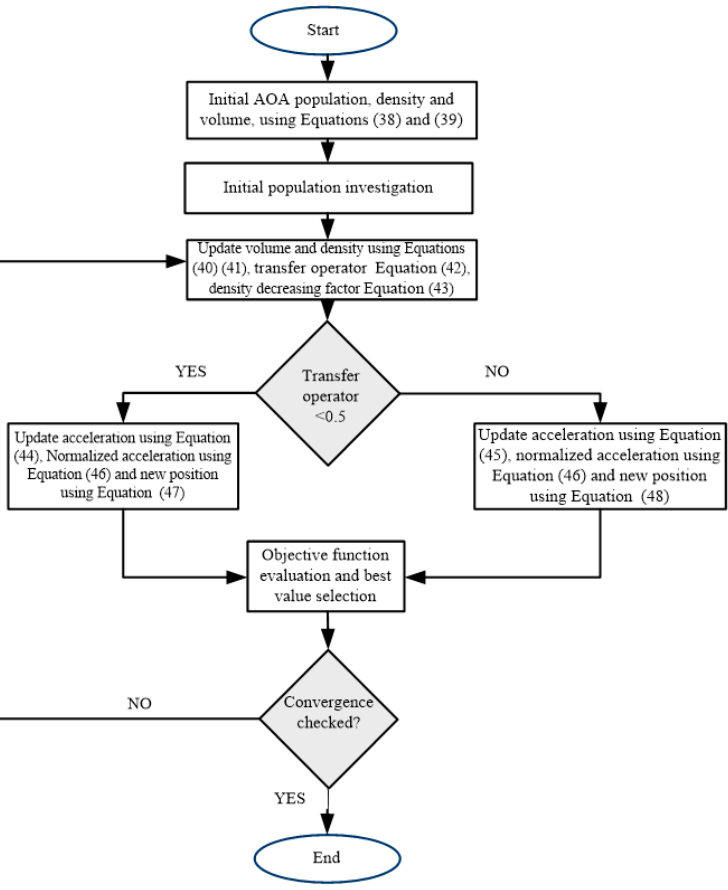
Figure 4. Working flowchart of the Archimedes optimization algorithm (AOA).